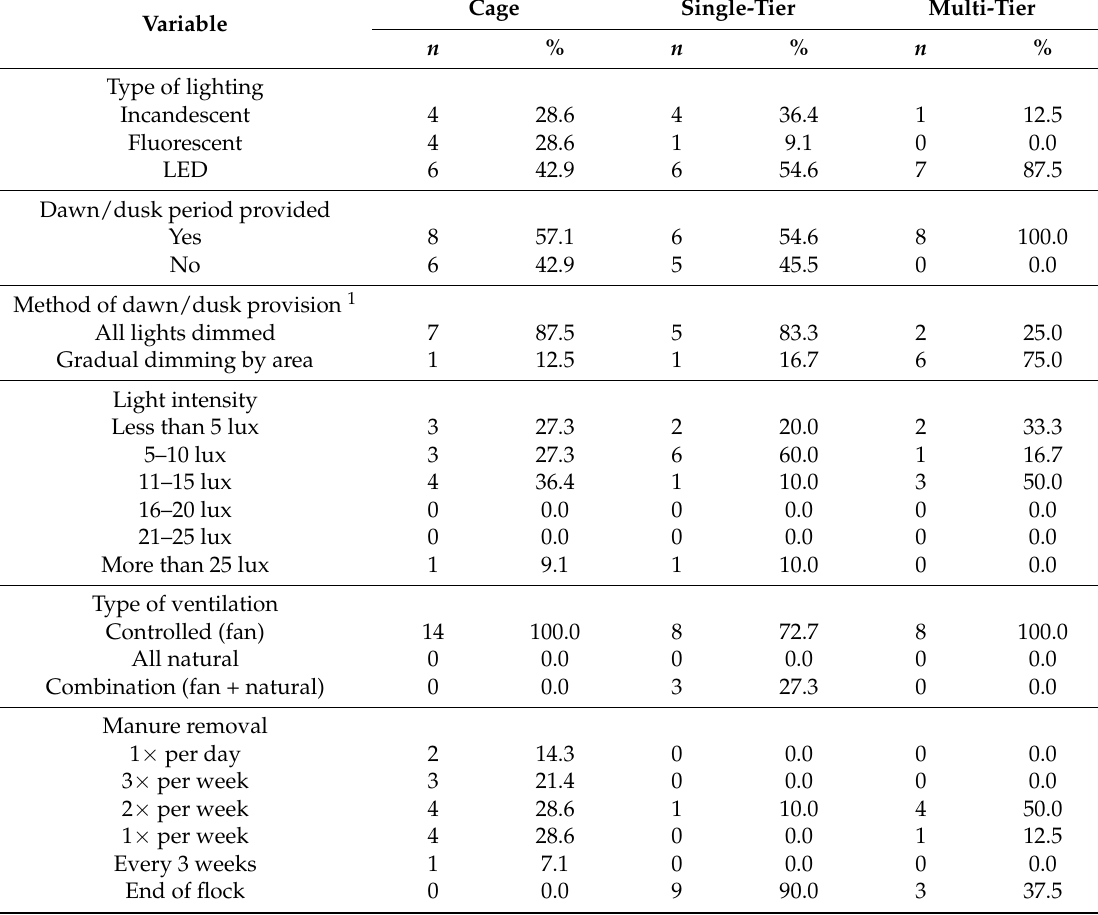
Table 5. Frequency of environmental control practices for 33 pullet flocks placed between May and November 2017 according to housing system (cage n = 14, single-tier n = 11, multi-tier n = 8) in Canada.